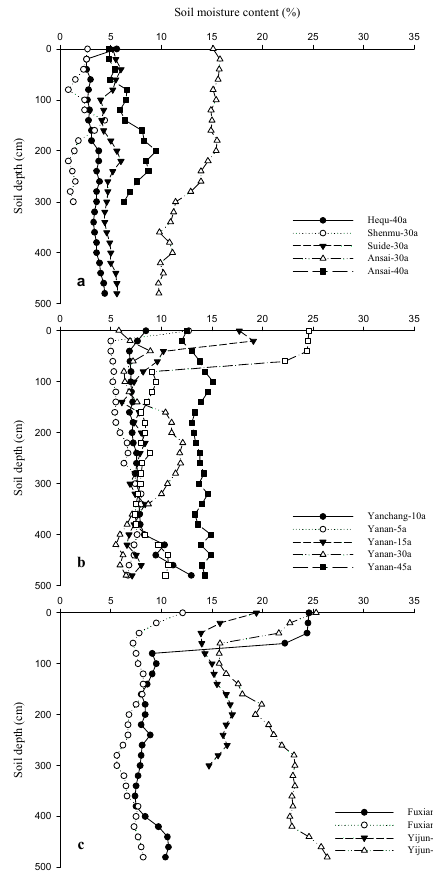
Figure 2. Vertical variation of soil-moisture content at R. pseudoacacia sites on the Loess Plateau of China. Note, ( a – c ) in Figure 2 were represented as the three different precipitation zones, namely, the typical northern, temperate, semi-arid, drought-prone steppe zone, the central, warm-temperate, semi-arid steppe zone, and the southern, warm-temperate, semi-humid forest-steppe zone, respec- tively. Arabic numerals indicate the forest-stand age of R. pseudoacacia plantation at each sampling site. In the southern, warm-temperate, semi-humid forest-steppe zone (Figure 2c), the av- erage SMC ranged from 7.49% to 21.03%, and the SMS varied from 486.72 mm to 1384.24 mm (Table 3). The SMCs of the RP-15a and RP-20a at Renjiatai were lower than the stable soil moisture (13.09%) and the natural-grassland control (19.19%), leading to different de- grees of soil desiccation. Meanwhile, their corresponding ASMS and soil-moisture over- consumption were 450.06 mm, 215.02 mm and 129.09 mm, 364.13 mm, respectively, and their average annual soil-desiccation rate reached 8.61 mm and 18.21 mm per year, which together indicated that soil-desiccation rate and soil-desiccation intensity gradually strengthened as the forest-stand age increased. However, the soil-moisture conditions of